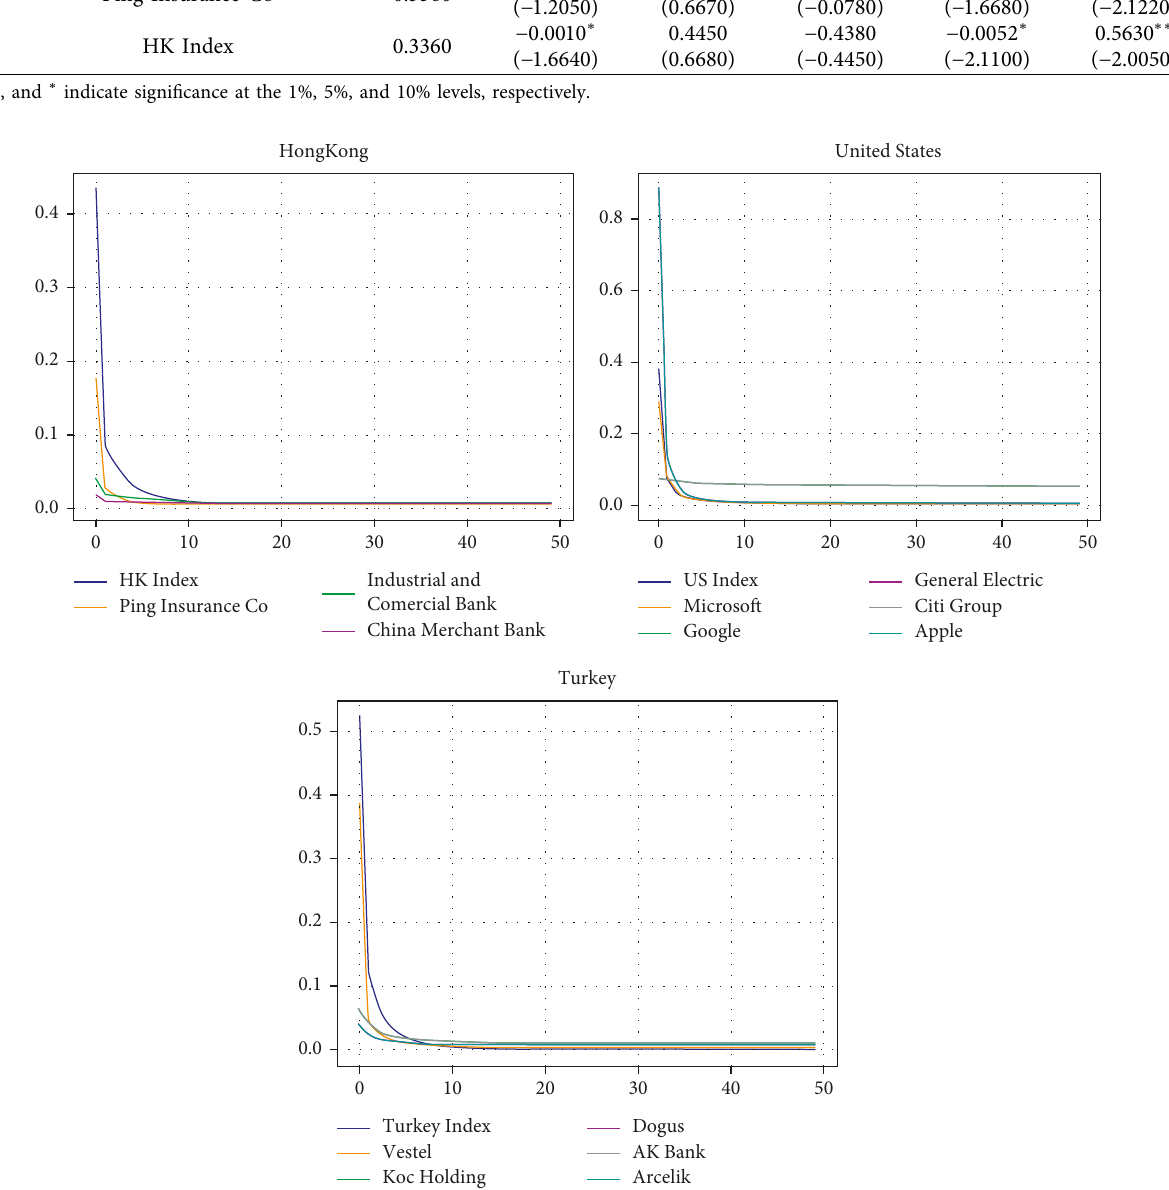
Figure 3: Training loss curves of the companies of different countries including Hong Kong, the United States, and Turkey without sentiments.